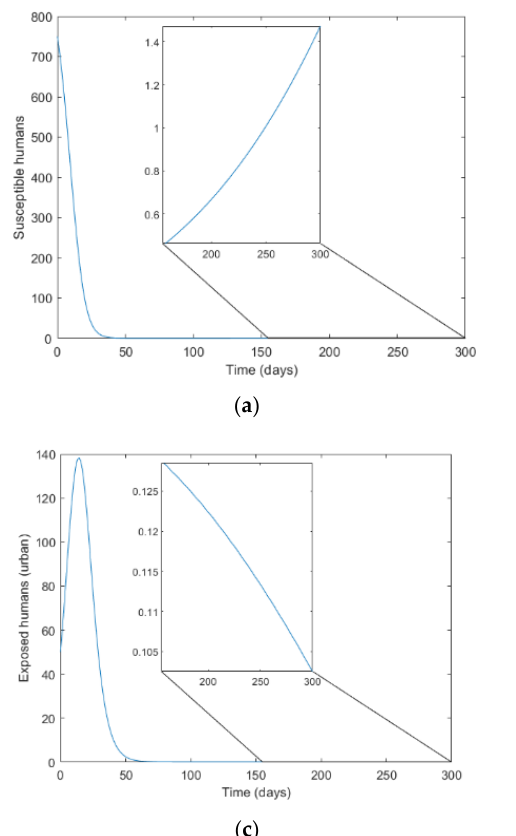
Table 2. The epidemiological parameters used in Equation (1).